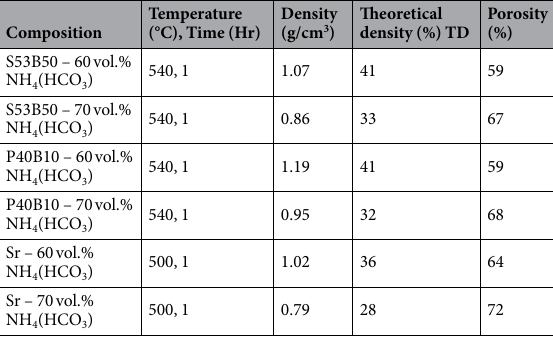
Table 3. Composition, Density and Open porosity of sintered